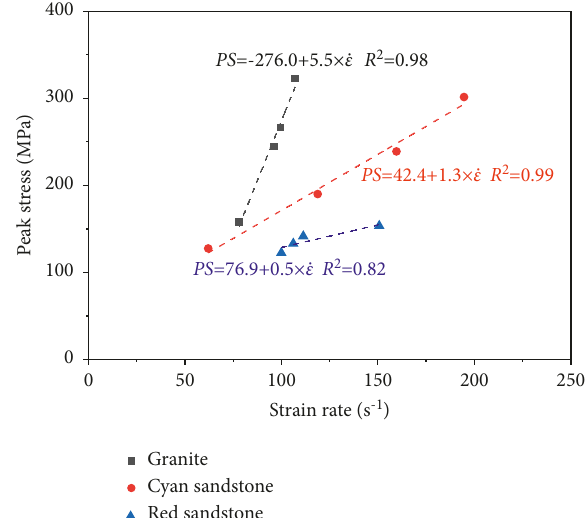
Figure 7: Relationship between the peak stress and the strain rate for the different types of rocks.